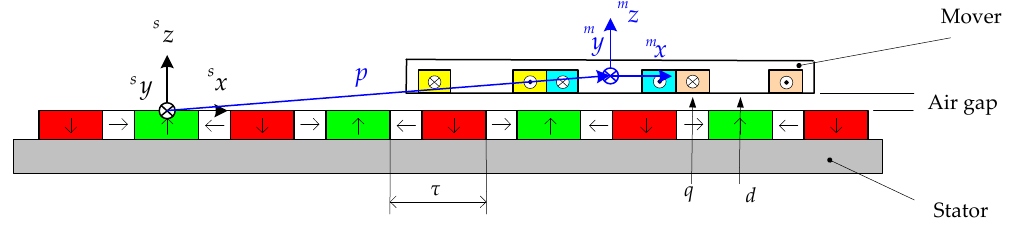
Figure 1. Coordinate system of maglev linear motor.